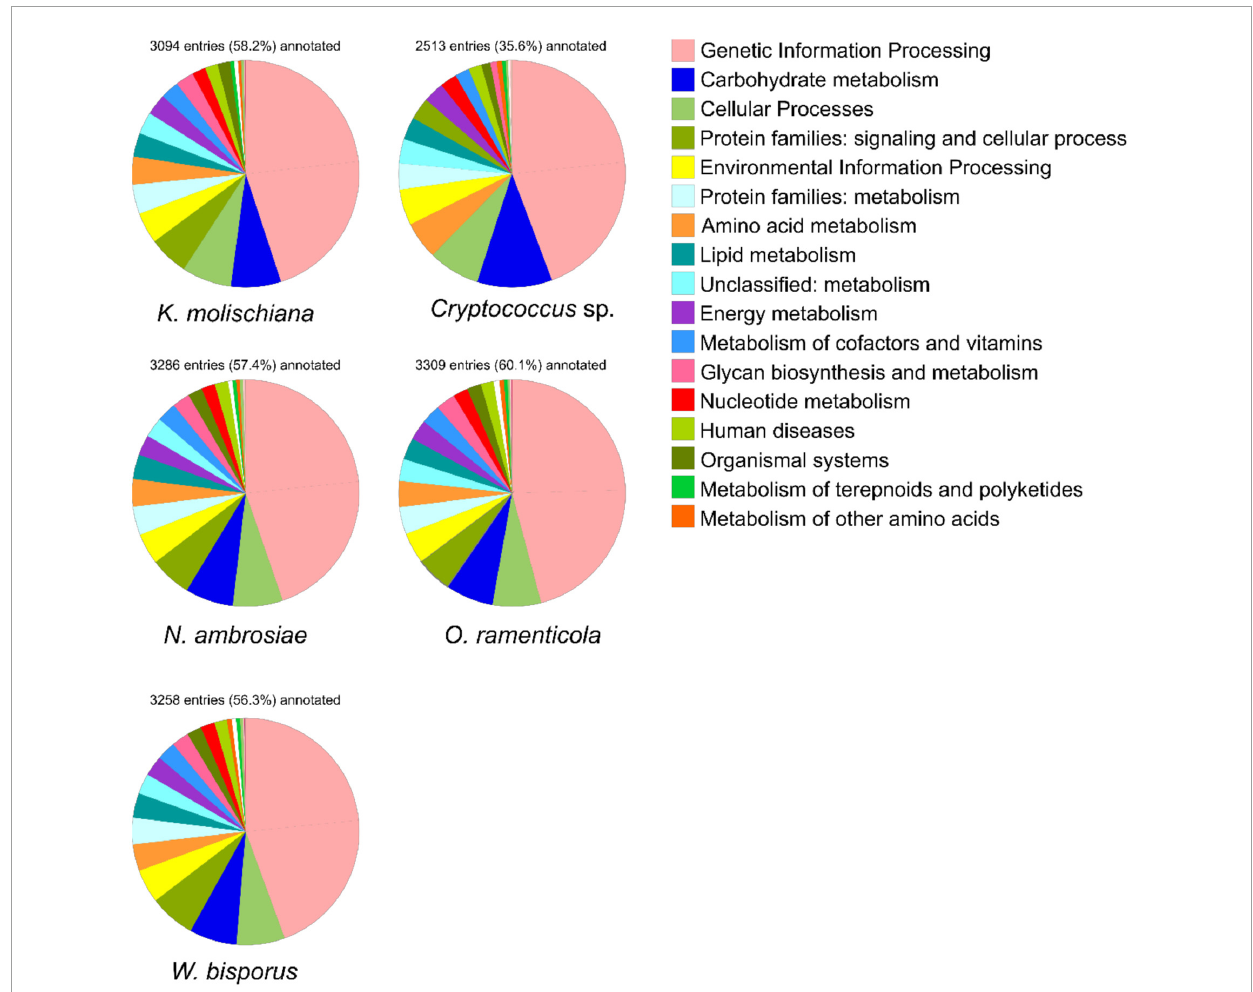
FIGURE2 Kyoto Encyclopedia of Genes and Genomes (KEGG) pathway annotation.